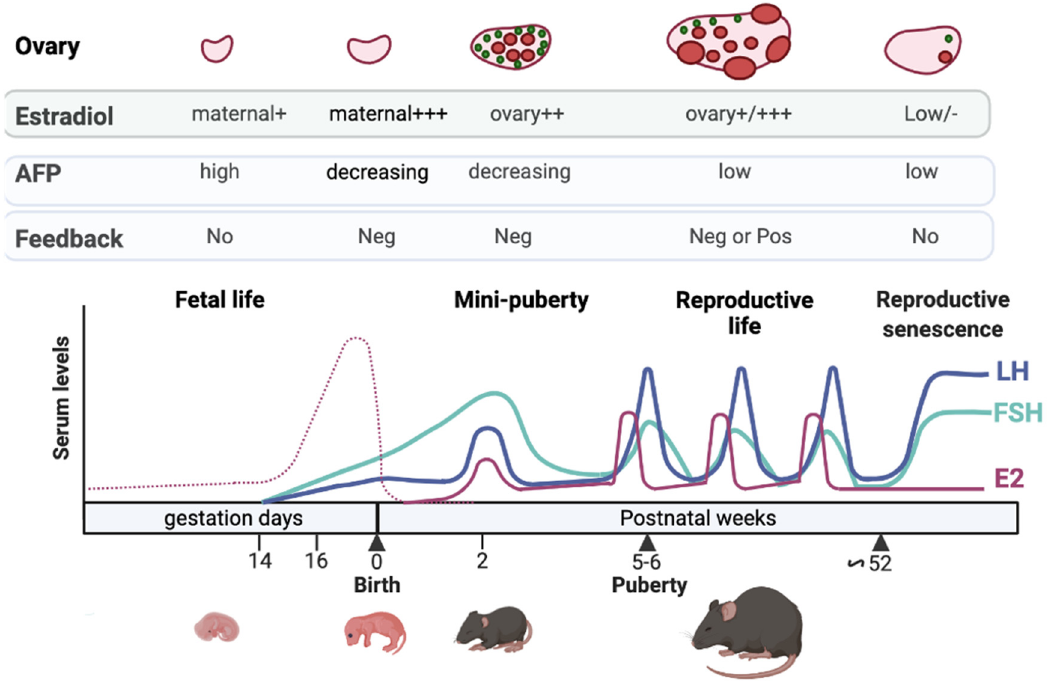
Figure 1. Regulation of the gonadotrope axis at different periods of life in the mouse. FSH (green line) and LH (blue line) are detected in the last part of gestation, induced by GnRH stimulation. The high levels of maternal estrogens (dotted pink line) may not exert negative feedback at this time on FSH and LH synthesis and secretion due to high levels of α -fetoprotein (AFP) produced by the fetal liver. After birth, maternal estradiol wanes from pup serum, and this may lead to the loss of estradiol negative feedback and to the dramatic rise in gonadotropin levels observed at the time of mini-puberty. Additional ovarian factors may contribute to this rise (see the text). The gonadotropin surge contributes to increased estradiol production by the ovary at mini-puberty (continuous pink line). After that, the decrease in AFP after birth, and the maturation of inhibin negative feedback, may contribute to the observed fall in gonadotropin levels, remaining low up to puberty. During reproductive life, gonadotropin levels are regulated by both estradiol negative and positive feedback. Estradiol negative feedback in aged mice is attenuated, thereby increasing gonadotropin levels. Note that the levels of hormones shown during the different periods are given on an indicative basis since no studies encompass all these periods. See references in the text.